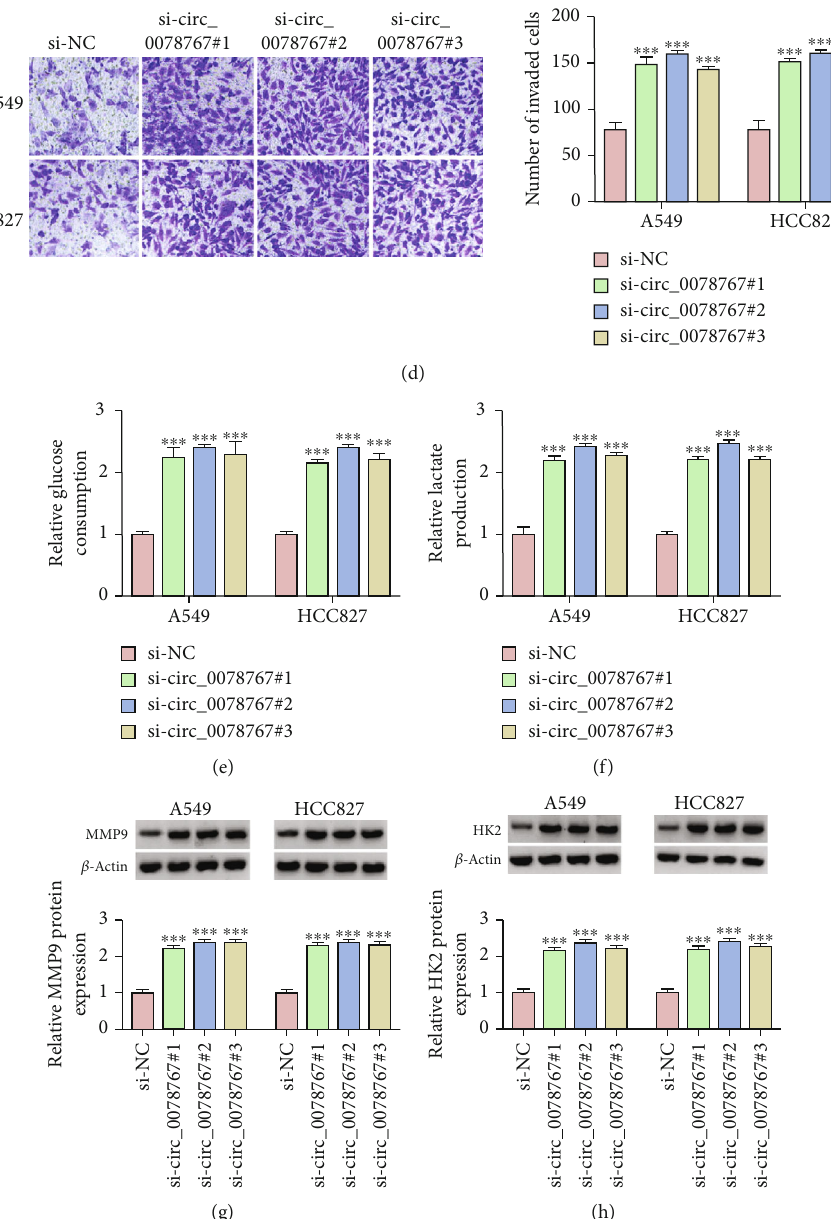
Figure 2: The functional roles of circ_0078767 on proliferation, migration, and invasion in NSCLC cells. (a) The expression level of circ_ 0078767 was determined by qRT-PCR assay in A549 and HCC827 cells transfected with si-NC or si-circ_0078767#1, si-circ_0078767#2, and si-circ_0078767#3. (b) Colony formation assay was used to assess proliferation of transfected A549 and HCC827 cells. (c, d) The role of circ_ 0078767 knockdown on cell migration and invasion was monitored by transwell assay. (e, f) Glucose consumption and lactate production were measured to assess glycolysis metabolism using commercial kits. (g, h) The protein expression level of MMP9 and HK2 was tested by Western blot analysis in transfected A549 and HCC827 cells. ∗∗∗ P < 0 : 001